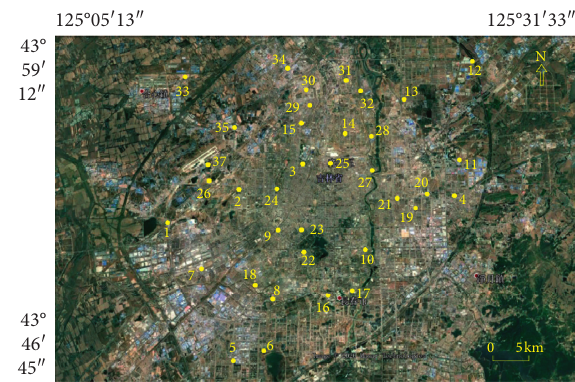
Figure 1: Sampling positions of the silty clay.